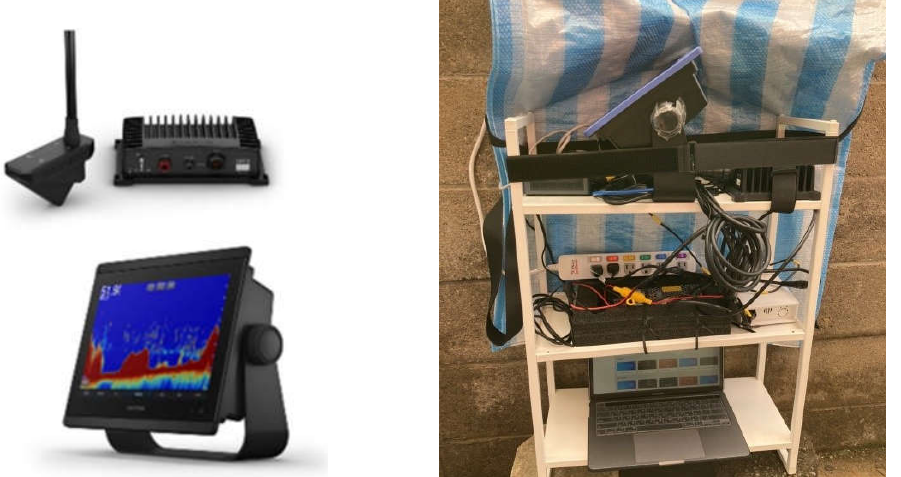
Figure 4. Sonar camera device used for data gathering.